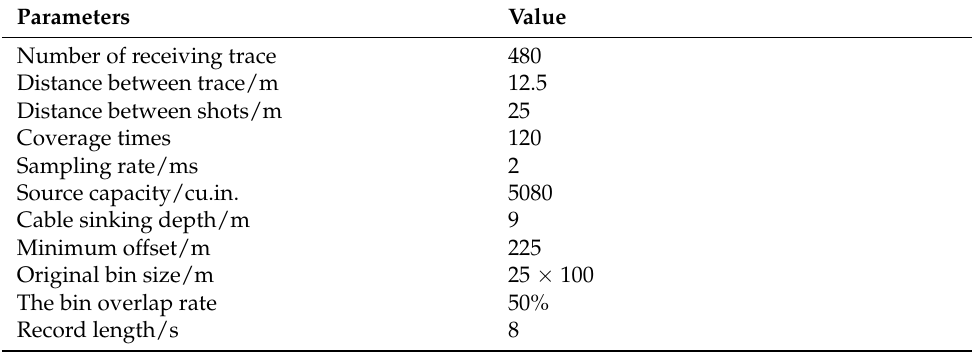
Table 1. Seismic acquisition